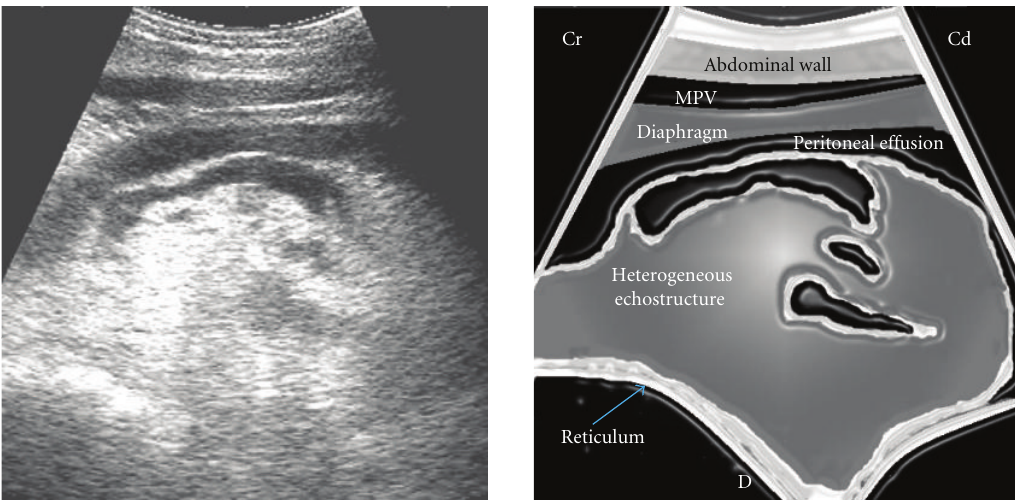
Figure 13: Left paramedian sonogram depicting deposition of the echogenic fibrin interspersed with the hypoechogenic fluid between the diaphragm and reticulum. MPV: musculophrenic vein; Cr: cranial; Cd: caudal; D: dorsal.